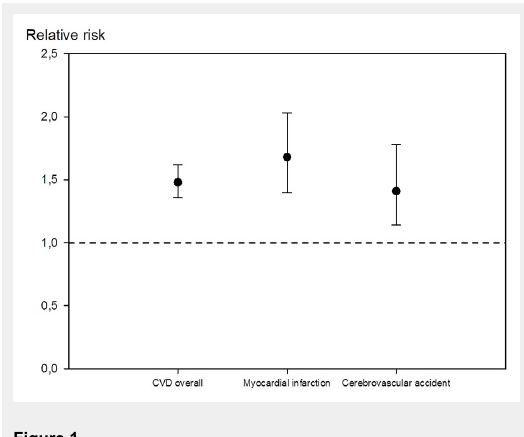
Pooled relative risks with 95% confidence intervals of cardiovascular disease (CVD) events in patients with rheumatoid arthritis compared to the background population. Based on data from a meta-analysis of 41490 patients in 14 observational studies (Avina-Zubieta et al. Ann Rheum Dis. 2012;71(9):1524–9